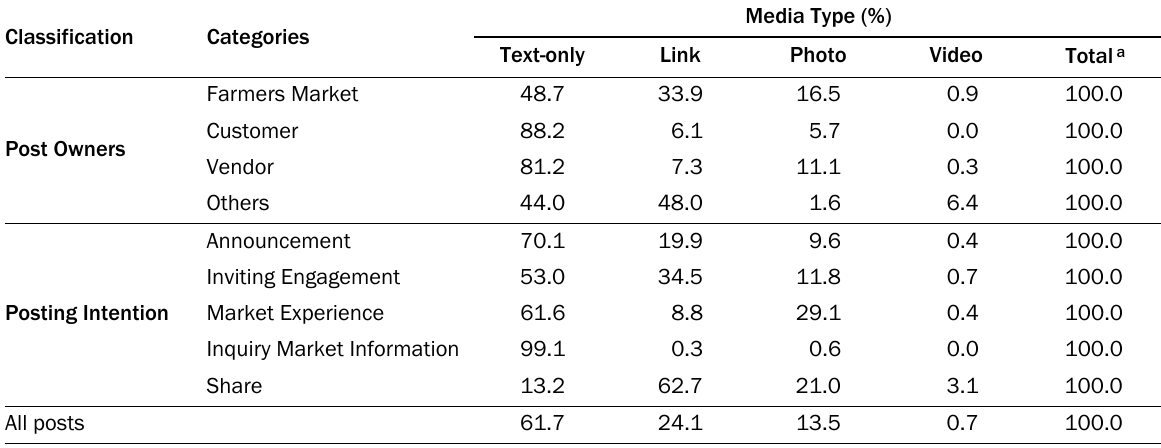
Table 2. Distribution of Posts ( N =6,369) by Post Owner, Posting Intention, and Media Type